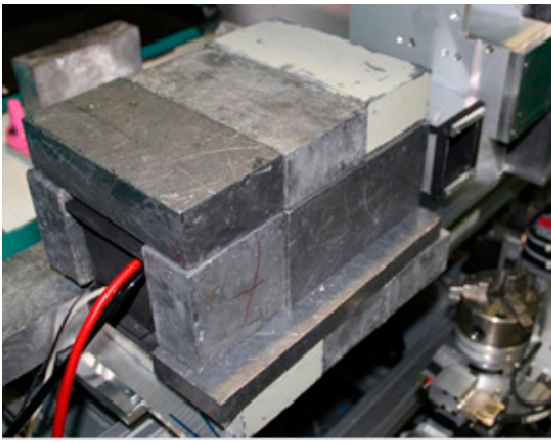
Figure 4. Detector with water cooler. Quantum Beam Sci. 2019 , 3 , x FOR PEER REVIEW